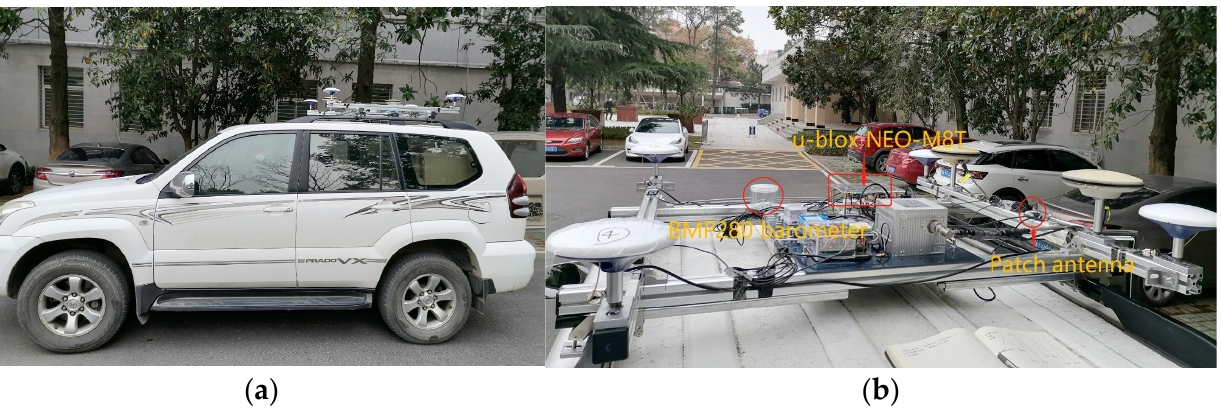
Figure 11. The mobile station hardware equipment site for kinematic vehicle experiment, including four geodetic GNSS receivers and antennas, NovAtel SPAN-FSAS GNSS/INS system, low-cost NEO-M8T receiver with a patch antenna, and a BMP280 barometer: ( a ) the experimental vehicle; ( b ) equipment setup diagram.